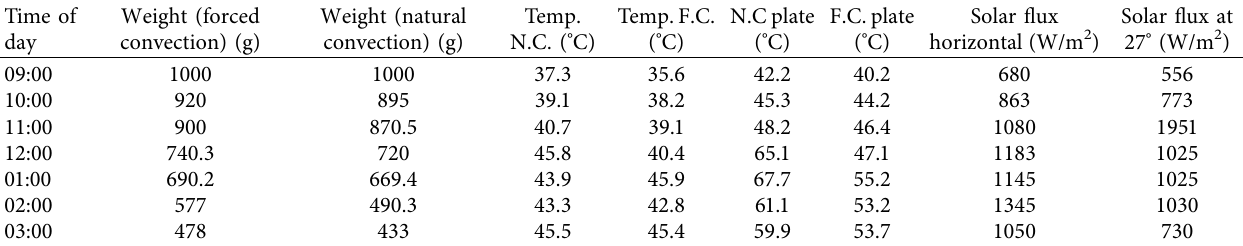
Table 5: Observation of fenugreek in solar dryer.